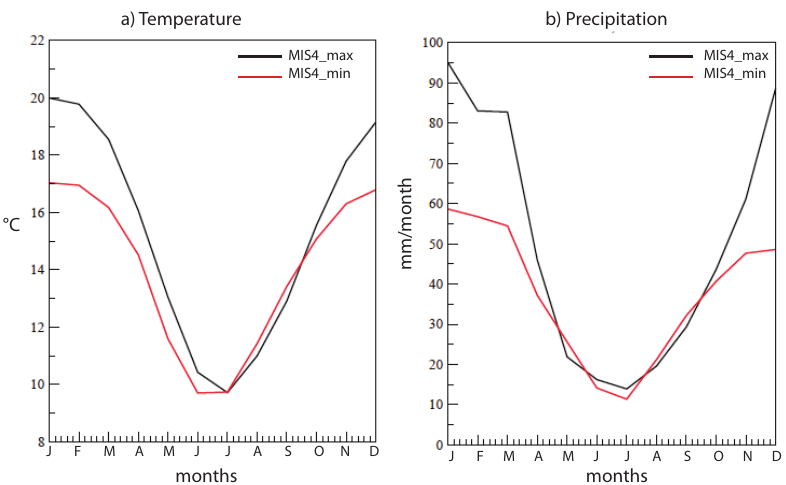
Figure 9. Annual cycle of (a) mean monthly temperatures ( ◦ C) and (b) mean monthly precipitation (mmmonth − 1 ) over the east of southern Africa (summer rainfall area, 37–25 ◦ S, 22–35 ◦ E simulated in MIS4_max (black) and MIS4_min (red) (IPSL_CM5A simulations, down- scaled to 0.16 ◦